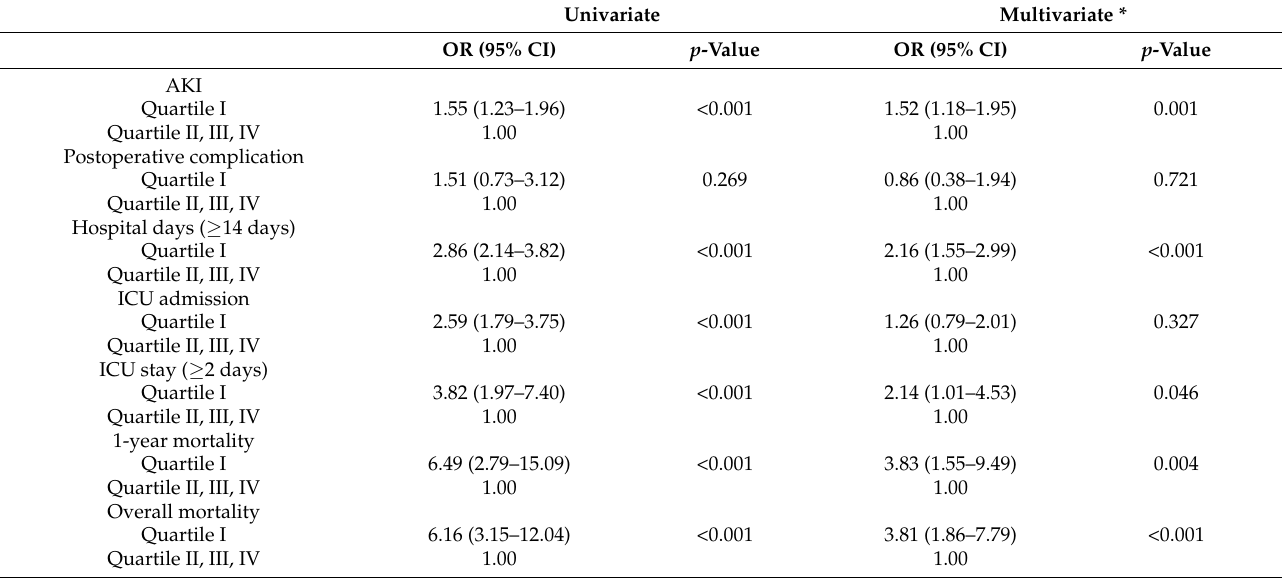
Table 4. AKI incidence and surgical outcomes adjusted by